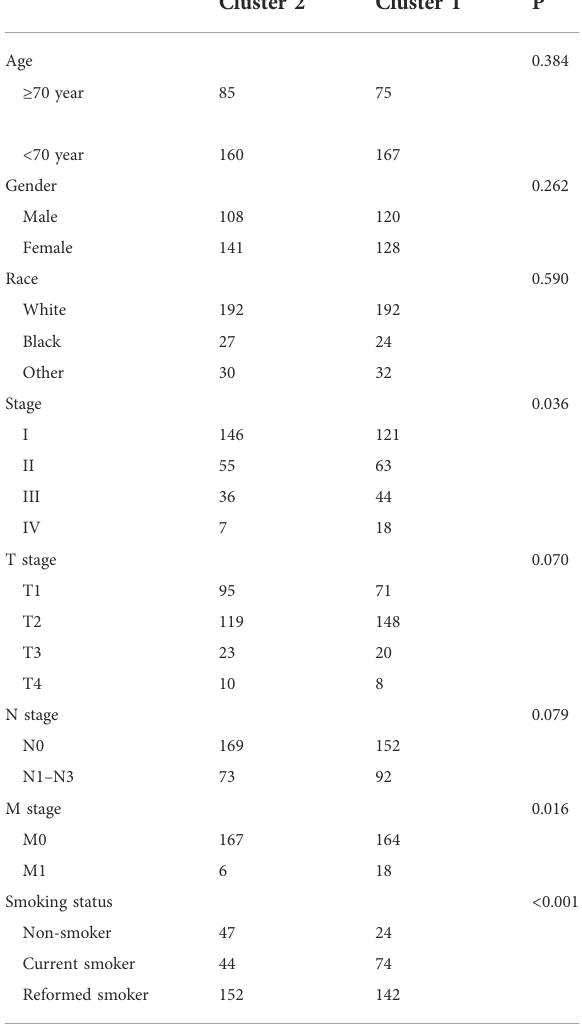
TABLE 1 Clinicopathological characteristics of